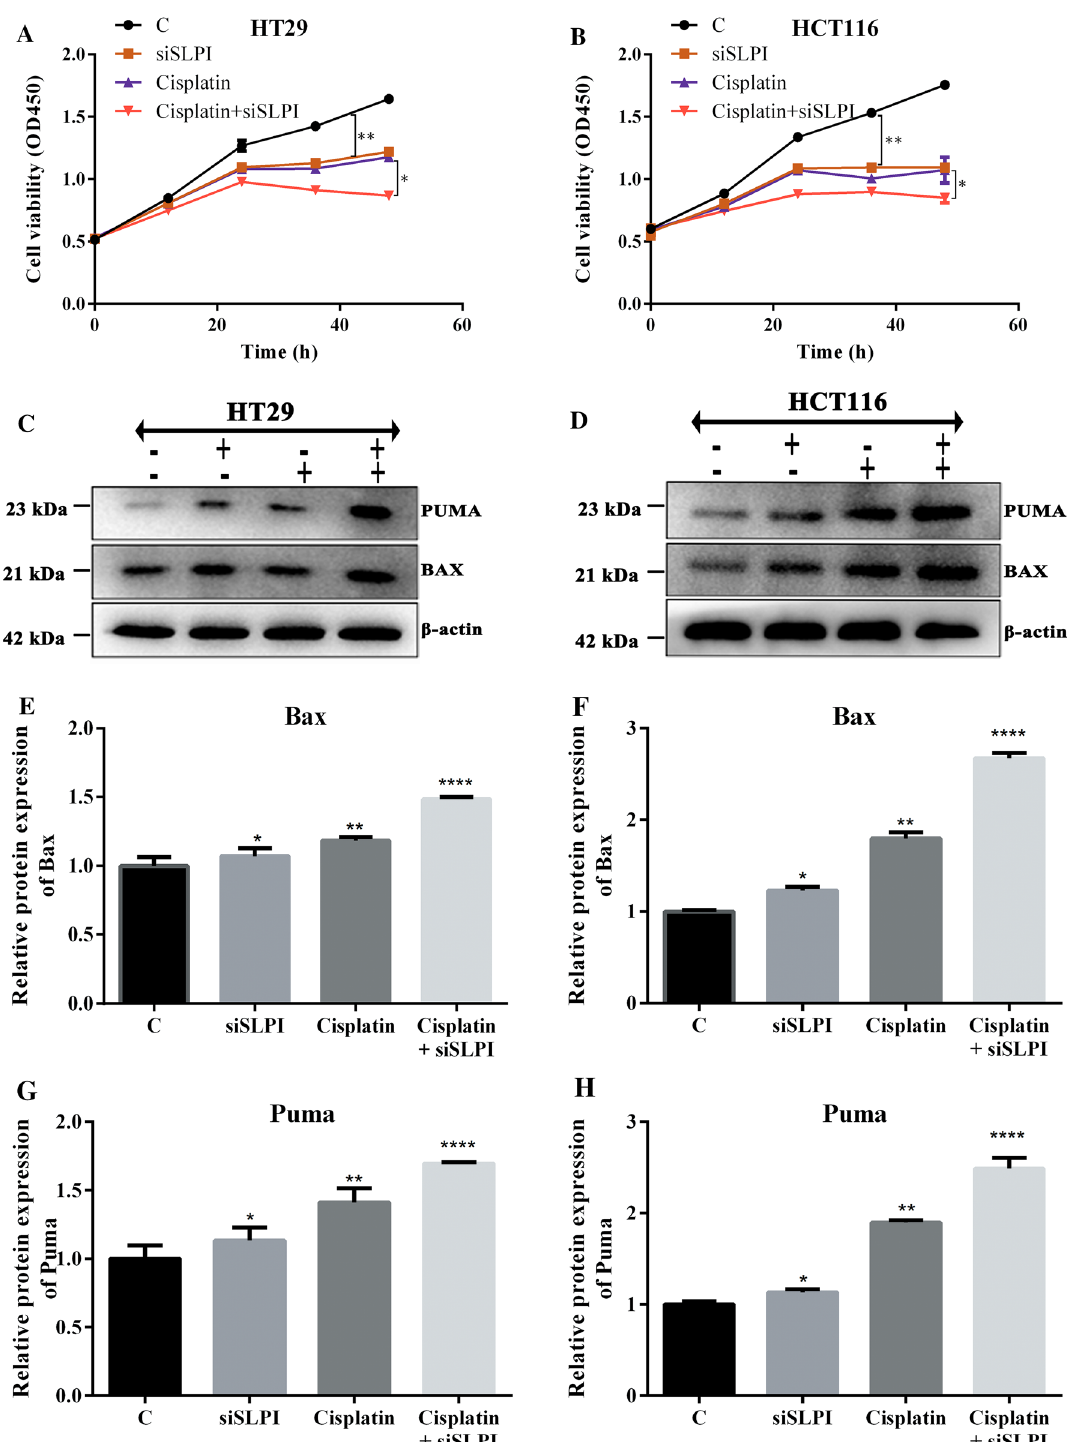
Fig. 4 siSLPI enhanced chemosensitivity of colon cancer cells to Cisplatin (200 nm). Relative viability of cell treated siSLPI, Cisplatin and Cisplatin + siSLPI, the combined treatment of both Cisplatin and suppression of SLPI exhibited the lowest cell viability ( A , B ). Western Blot results showing how the suppression of SLPI coupled with cisplatin treatment induced higher expression levels of PUMA and BAX proteins than that of HT29 cells treated with Cisplatin or siSLPI alone ( C , D ). Scale bar representation of the protein expressions of PUMA and Bax respectively ( E – H ). *p < 0.05; **p < 0.1, and ****p <